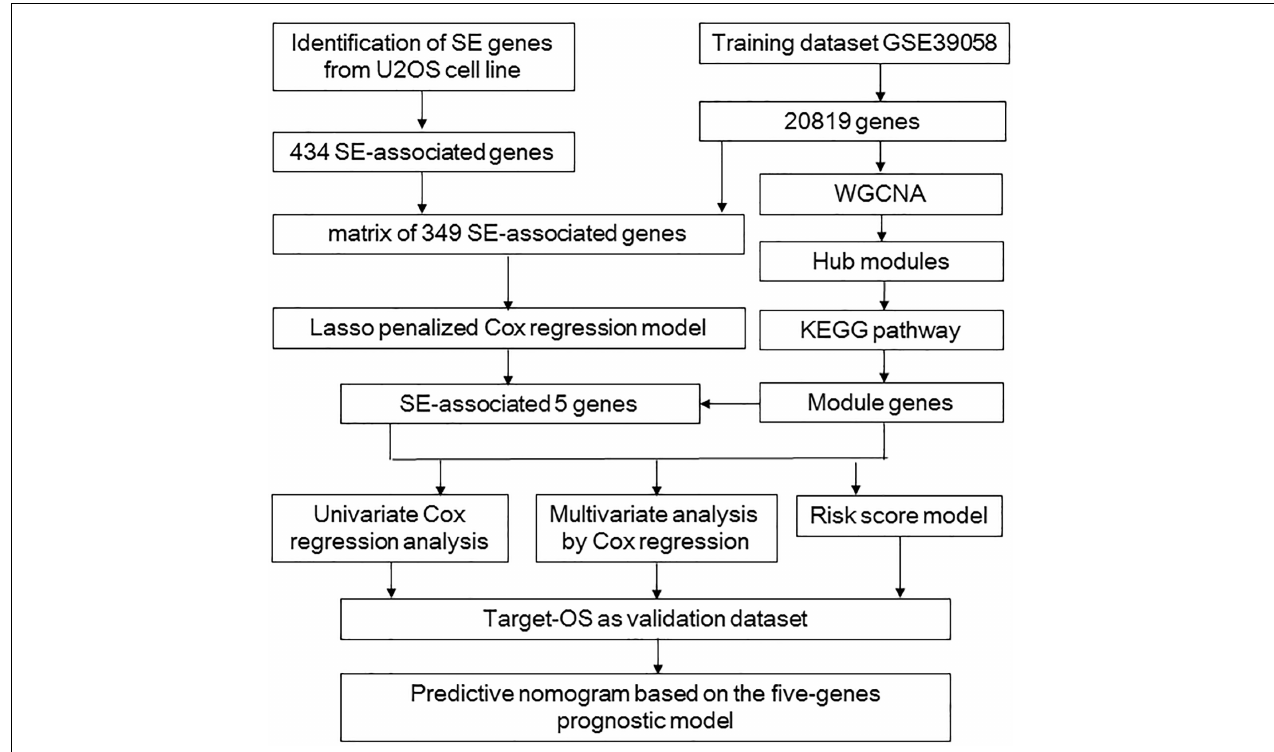
FIGURE 1 | The procedure workflow used to establish and certify the SE-associated gene-based prognostic model for patients with osteosarcoma. KEGG, Kyoto Encyclopedia of Genes and Genomes; Lasso, least absolute shrinkage and selection operator; Target-OS, Target-osteosarcoma; SE, super-enhancer; WGCNA, weighted gene co-expression network